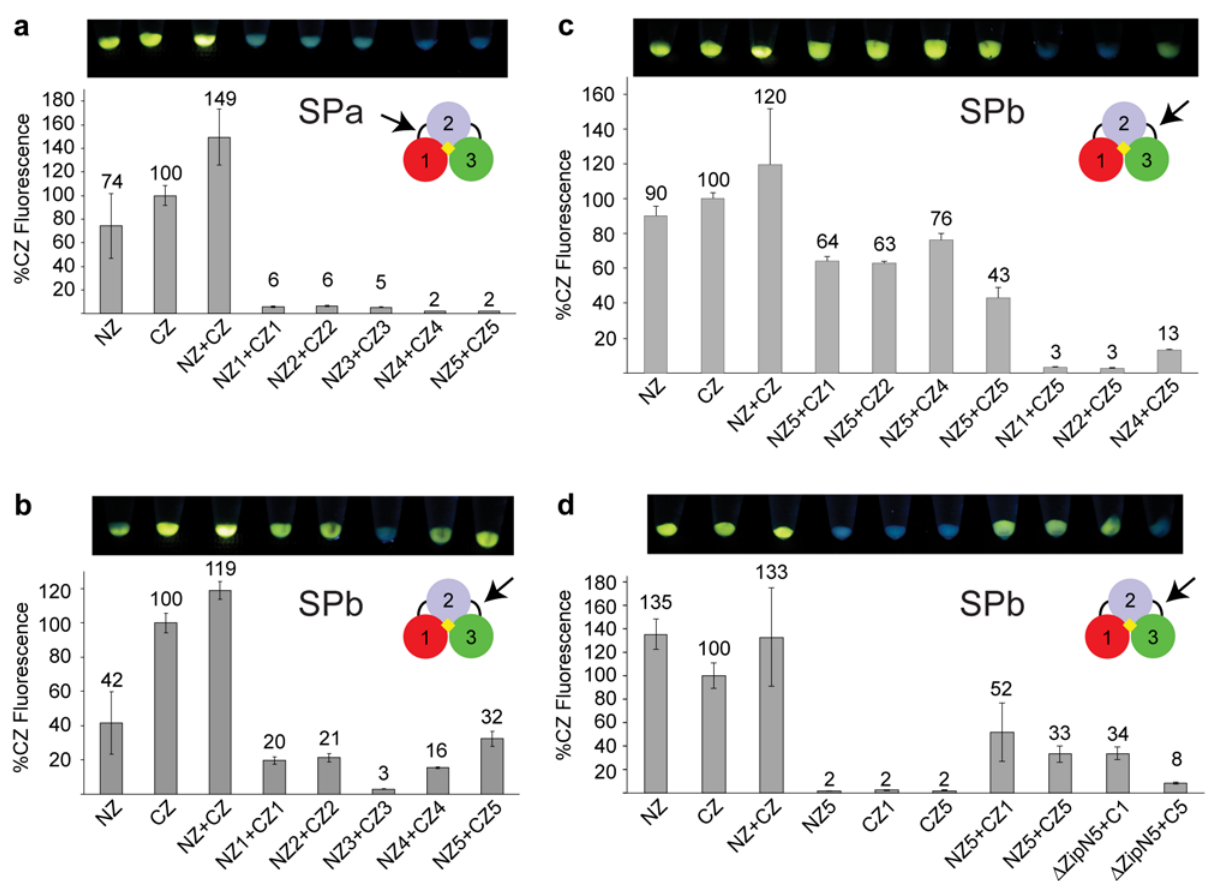
Fig 5. LucY reassembly. (a) Five split points between domains 1 and 2, referred to as SPa NZ or CZ 1 – 5, were fused with leucine zippers and co- expressed. Image above each graph shows whole cell pellets of corresponding sample under UV light. Fluorescence is represented as a percentage of CZ. Error bars represent standard deviation from the mean (n = 3). (b) Five split points between domains 2 and 3 (SPb NZ or CZ 1 – 5) were fused with leucine zippers and co-expressed. (c) SPbNZ5 was paired with other split points to determine pair with highest fluorescence. (d) SPbNZ5 paired with either SPbCZ1 or SPbCZ5, was tested for fluorescence independently and without leucine zipper ( Δ